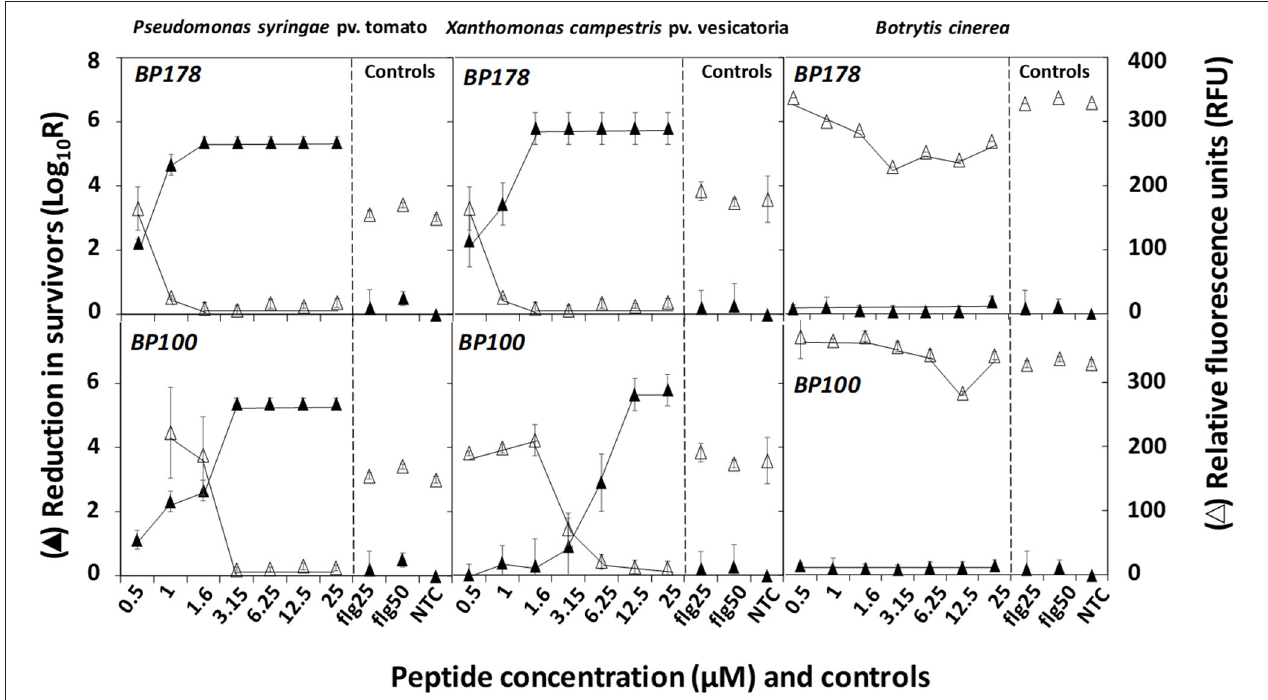
FIGURE 1 | Effect of peptides BP178 and BP100 in cell survival (black triangles) and resazurin cell viability (white triangles) of Pseudomonas syringae pv. tomato, Xanthomonas campestris pv. vesicatoria, and Botrytis cinerea after exposure to the peptides for 60min. Controls of flg15 at 25 (flg25) or 50 µ M (flg50) and non-treated (NTC) were included. Values are the means of three replicates, and error bars represent standard deviation of the mean.